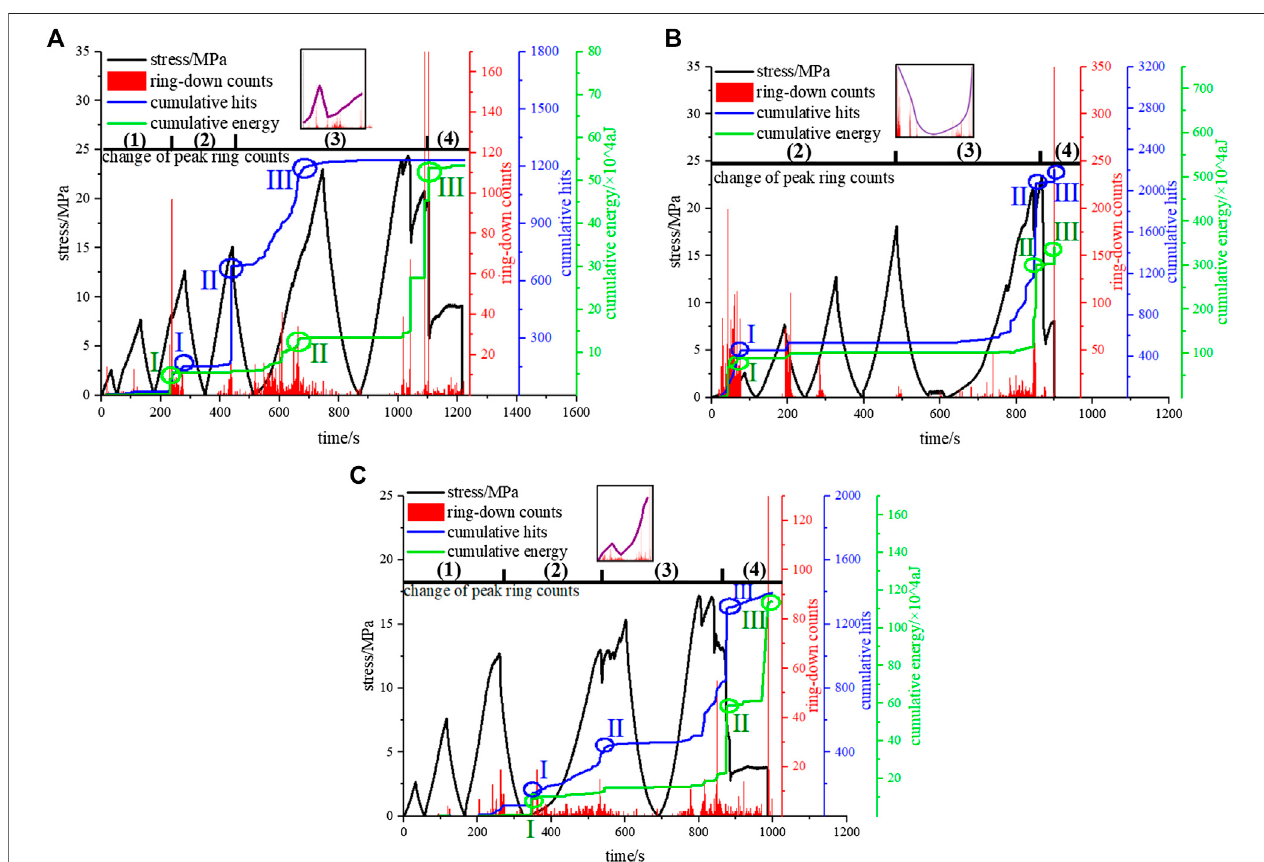
FIGURE 3 | AE test results under different loading rates. (A) v (cid:2) 0.15 mm/min; (B) v (cid:2) 0.2 mm/min; (C) v (cid:2) 0.3 mm/min: 1) slight increase period; 2) attenuation period; 3) intense growth period; 4)the postpeak calm period.